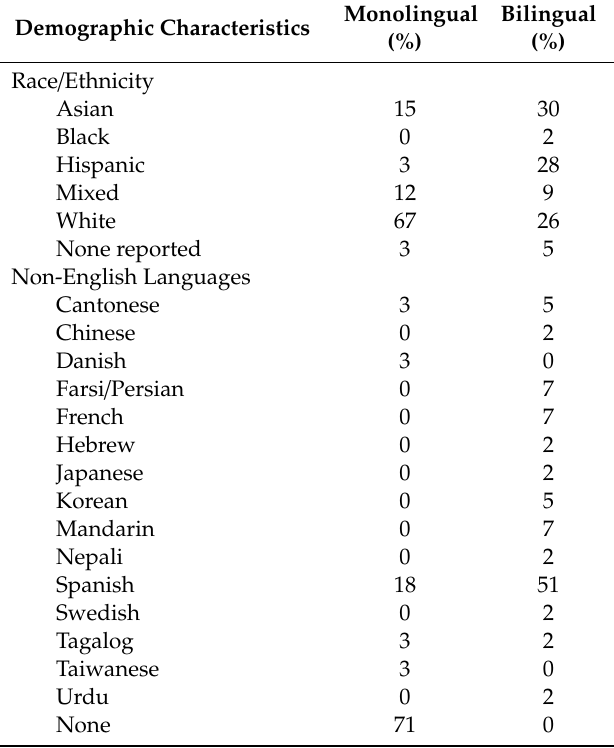
Table 1. Demographic information by language background.